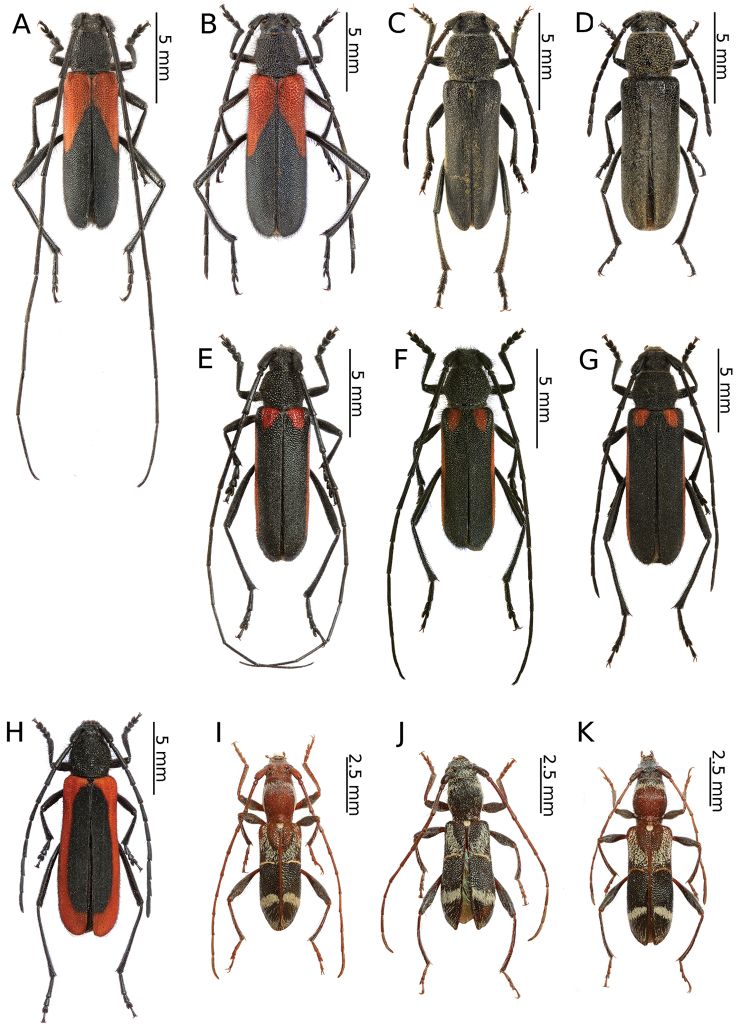
Photos of longhorn beetles specimens collected during the expedition to Kazakhstan in 2017: AAnoplistesjacobsoni (male) BA.jacobsoni (female) CAnoplistesgalusoi (male) DA.galusoi (female) EAnoplisteshalodendrihalodendri (male, Sibinka River valley) FA.halodendrihalodendri (male, Tarbagatay environs) GA.halodendrihalodendri (female, Sibinka River valley) HAmarysiusduplicatus (female) ICleroclytussemirufuscollaris (male, light form) JC.semirufuscollaris (male, dark form) KC.semirufuscollaris (female, light form).